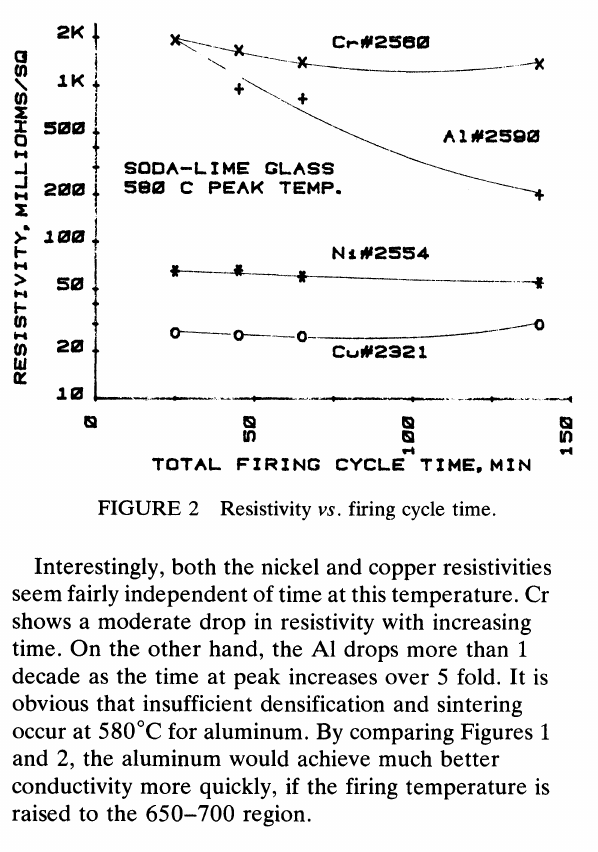
TABLE II Compatibility with #M-4023B dielectric. All cofired at 580C for 45 min. cycle, dried between each